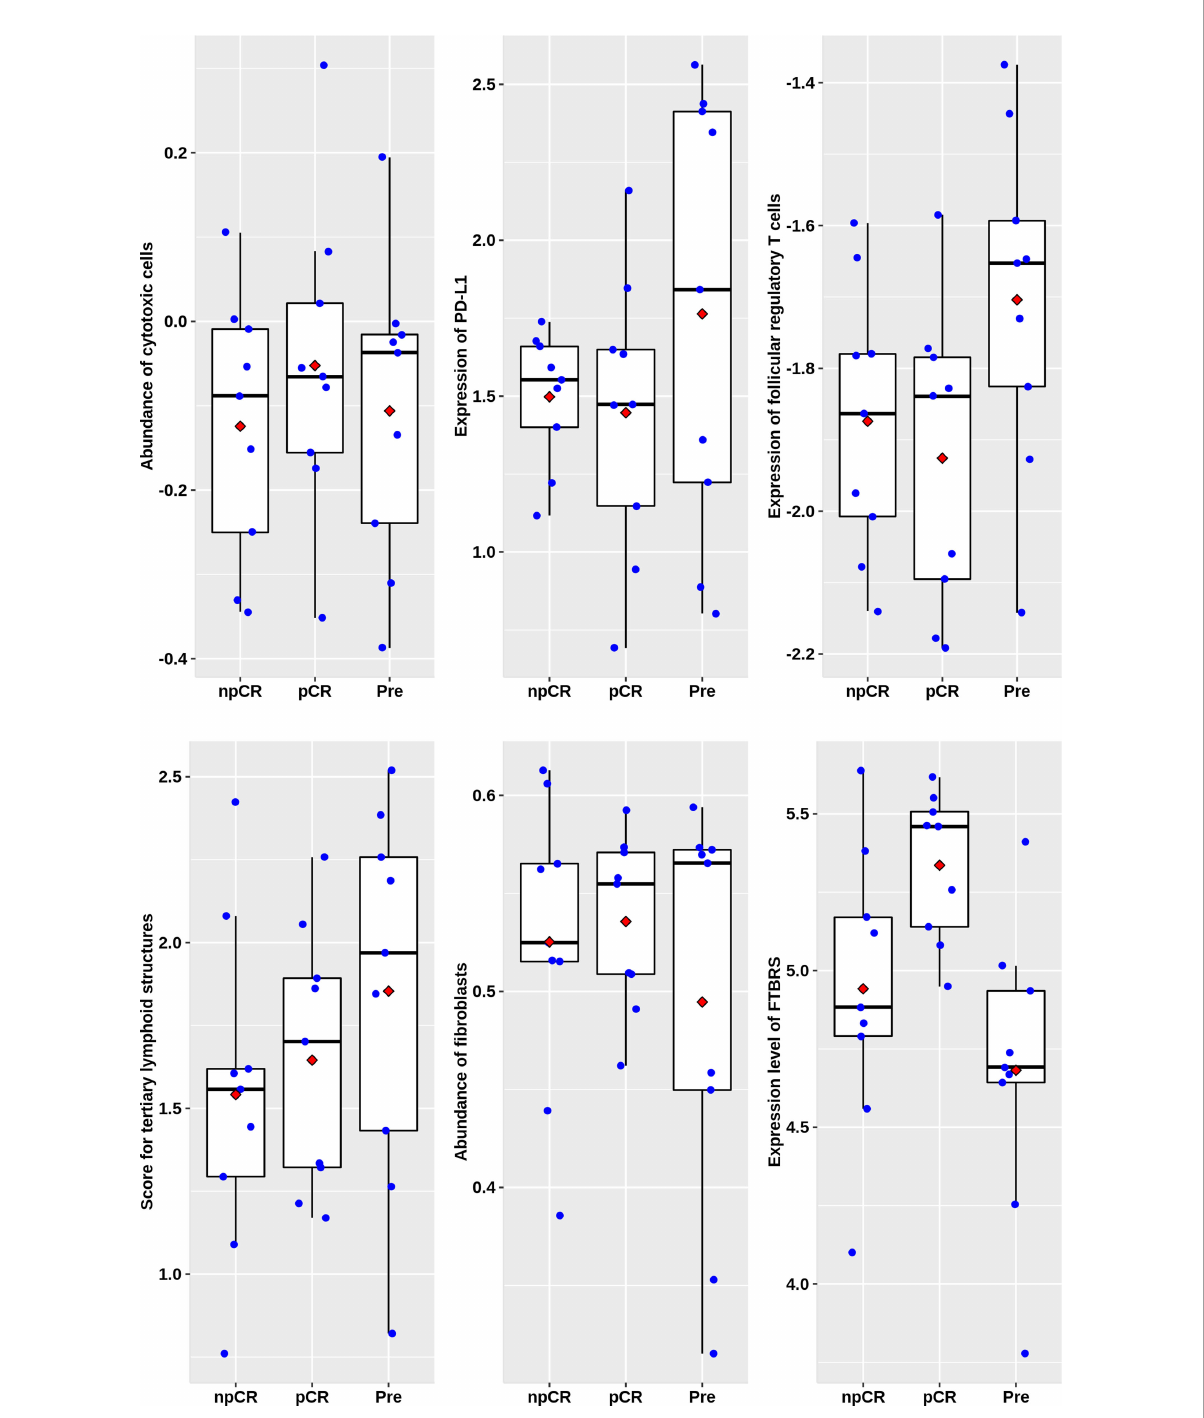
FIGURE 6 Scatter plots overlapped with box plots illustrating differences in six major immune related scores among four immune subtypes in DPH cohort. npCR indicates samples with non-pathological complete response after nCRT treatment, pCR indicates samples with pathological complete response after nCRT treatment and Pre stands for samples biopsied before